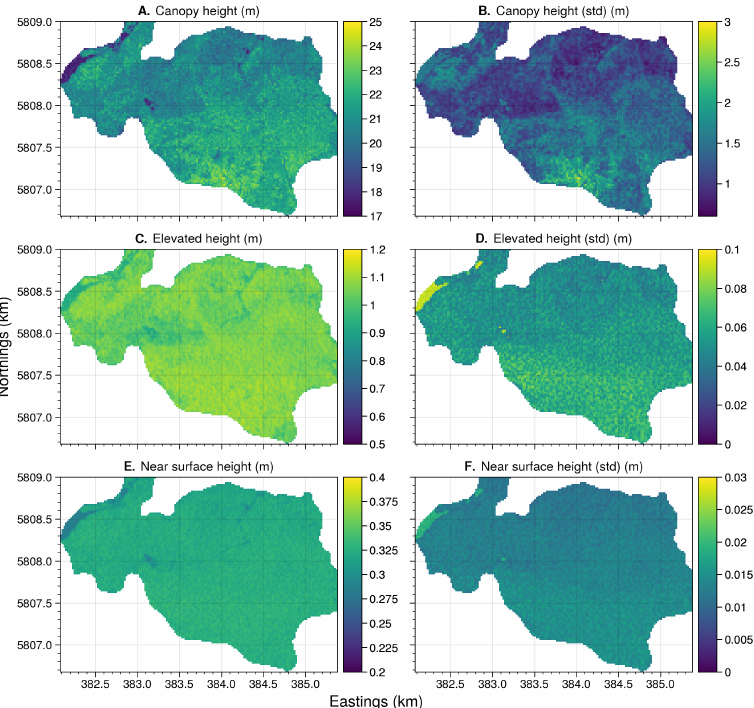
Figure A15. The mean and standard deviation predictions at landscape level for canopy ( A , B ), elevated ( C , D ), and near-surface ( E , F ) fuel height using TLS observations at Three Bridges.